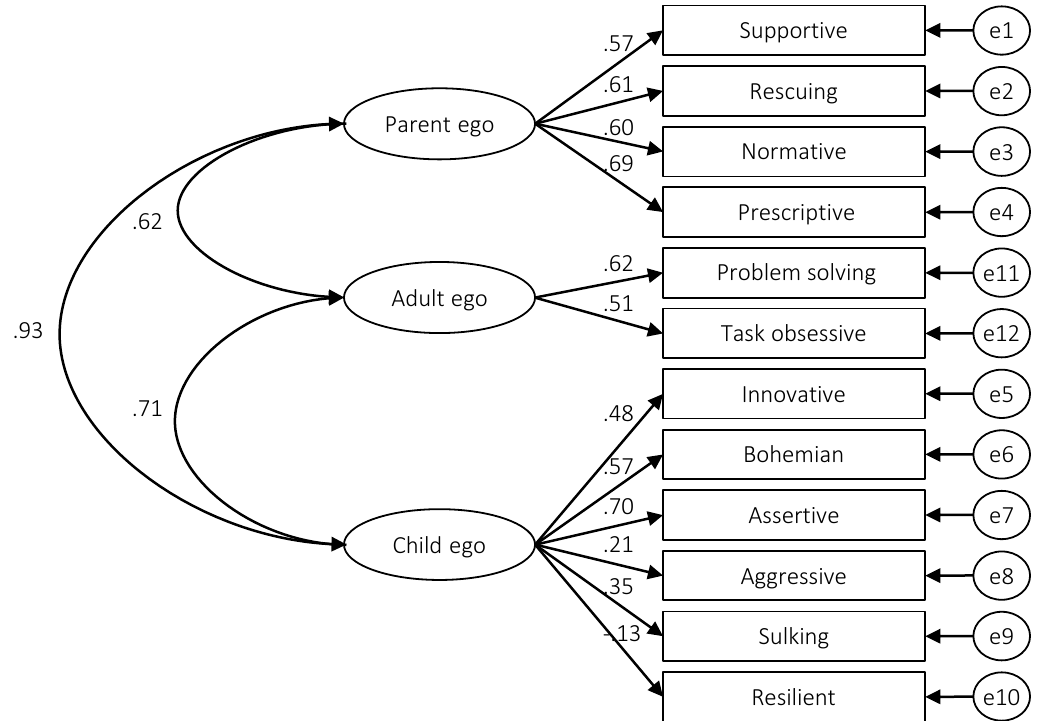
Figure 3. Structural equation model of interpersonal styles impact on ego